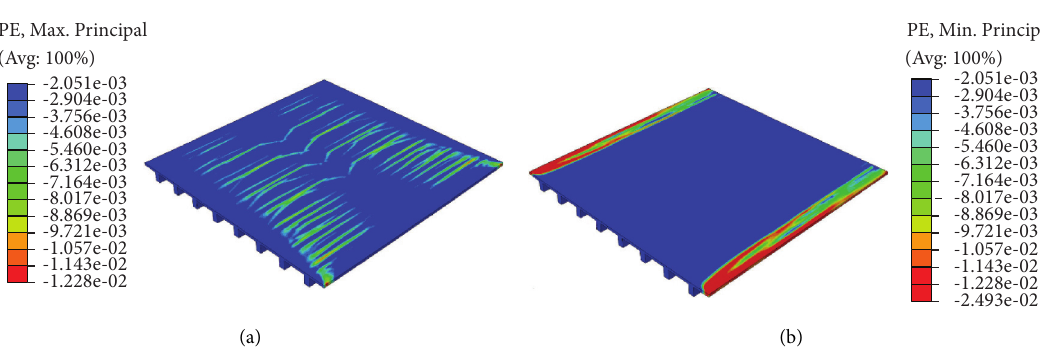
Figure 11: Distribution of cracks caused by corrosion in the concrete slab at 15mm displacement. (a) Distribution of cracks caused by concrete crushing in the model with X-ray loading. (b) Distribution of cracks caused by concrete crushing in the model with Z direction